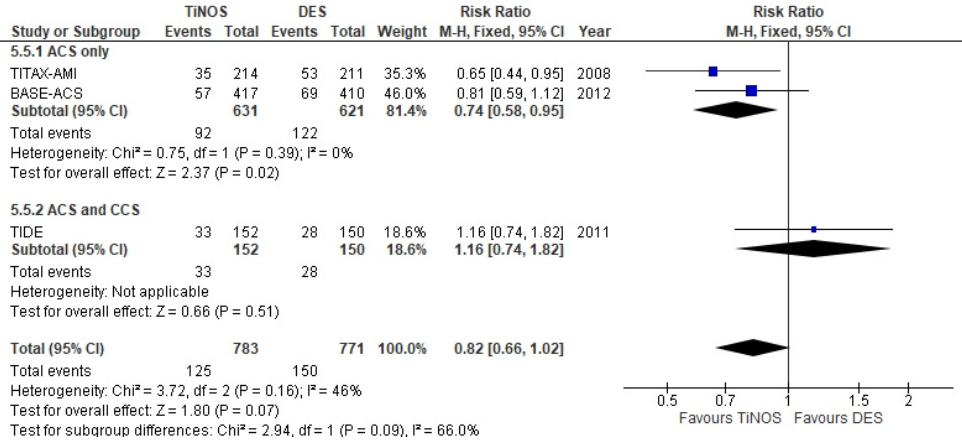
Figure 5. MACE—5 years.